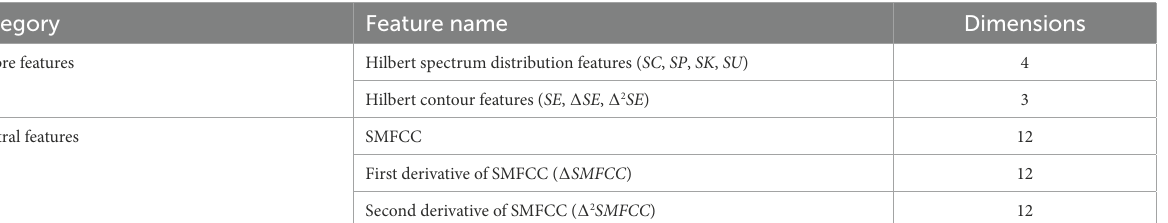
TABLE 3 The feature sets extracted by IMEMD for